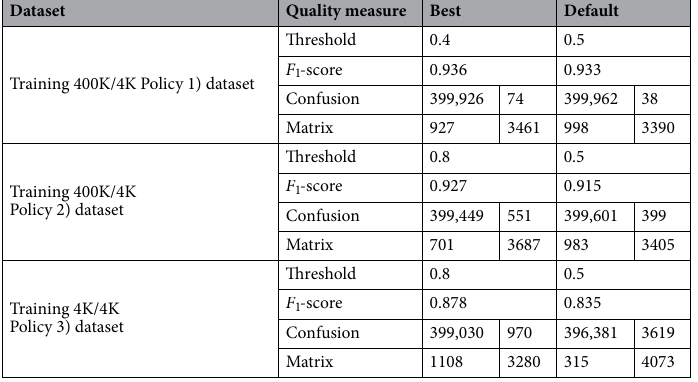
Table 5. Performance of synthetic traffic generated by standard WGANs. Results on testing using the best models on